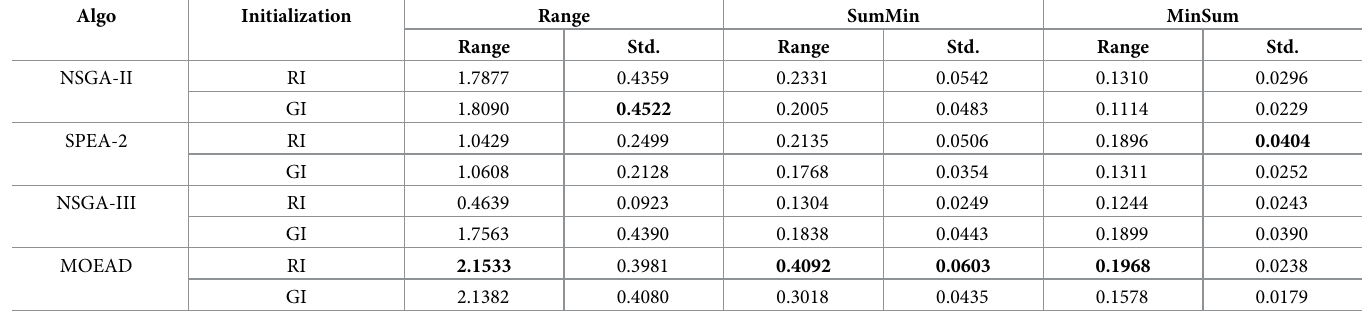
Table 4. Performance comparison of algorithms using measures of range, SumMin, and MinSum. GI stands for greedy initialization, RI stands for random initialization. Algo